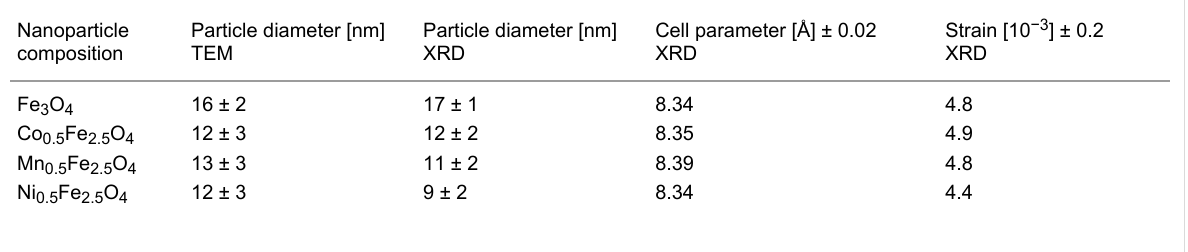
Table 1: Diameter of nanoparticles determined from TEM images and estimated average grain diameters, unit cell parameters and strain values from the most intense XRD patterns.